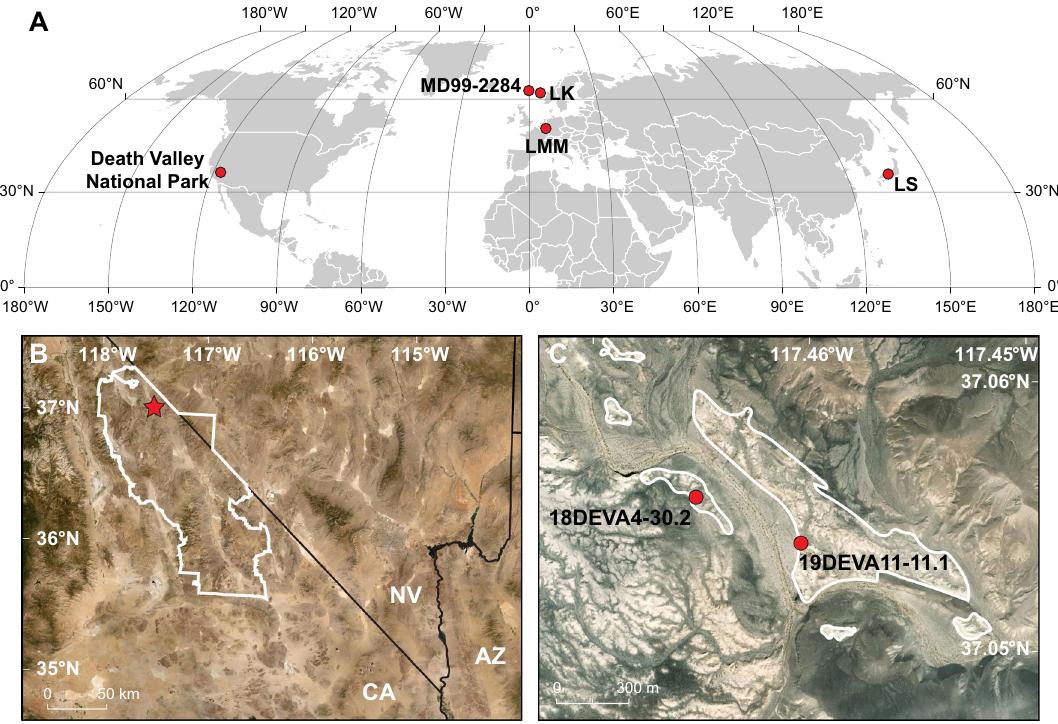
Figure 1. ( a ) Locations of sites where unequivocal evidence of a two-stage Younger Dryas (YD) climate event has been documented. Death Valley National Park; MD99-2284 = marine core in the Faeroe-Shetland passage off the coast of Norway 16 ; LK = Lake Kråkenes, Norway 16 ; LMM = Lake Meerfelder Maar, Germany 14 ; LS = Lake Suigetsu, Japan 20 . ( b ) Location of Death Valley National Park (white line) in the southwestern U.S. AZ = Arizona, CA = California, NV = Nevada. Red star shows the location of the current study. ( c ) Locations of key stratigraphic sections, 19DEVA11-11.1 (11S, 459157 m E, 4100907 m N) and 18DEVA4-30.2 (11S, 458705 m E, 4101050 m N) (red circles), and the spatial extent of YD-aged spring deposits in the basin (white